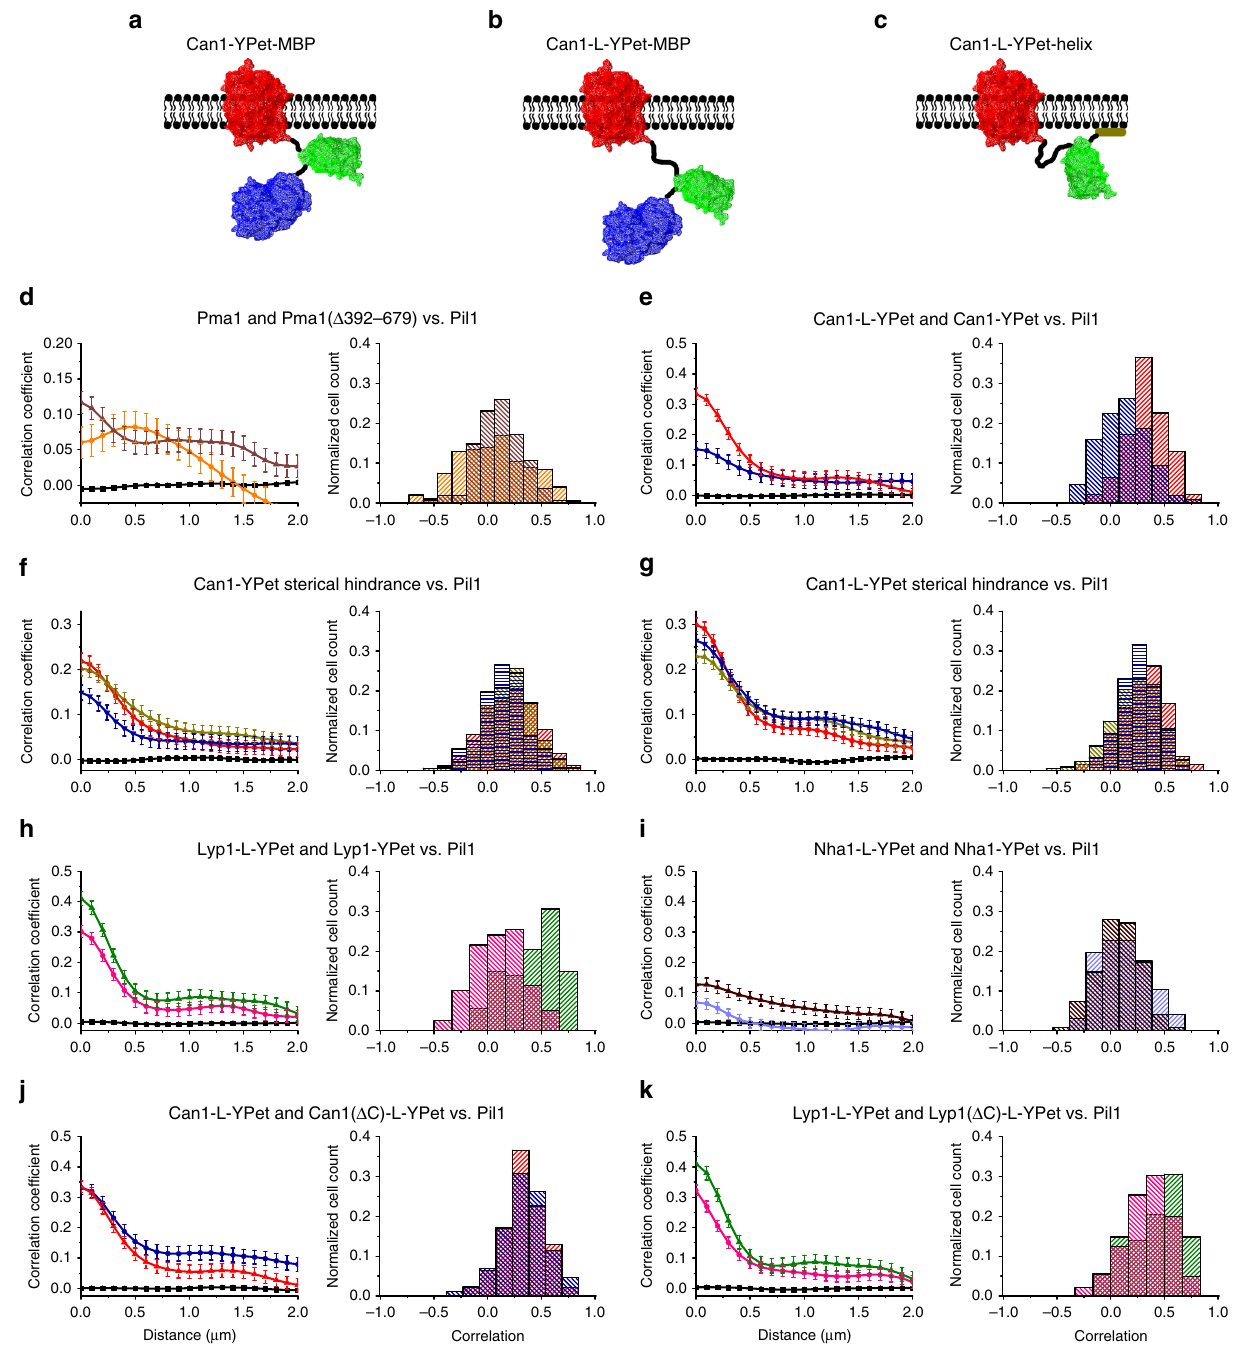
Fig. 5 Steric occlusion from MCC/eisosomes. Schematic of transporter constructs ( a – c ) to investigate the possible hindrance for MCC/eisosome entry by engineering cytoplasmic domains onto Can1. Maltose-binding protein (MalE) (blue) attached to c Can1-YPet and d Can-L-YPet, and e Can1-L-YPet tethered to the membrane via an amphipathic α -helix and lipid moiety; the helix corresponds to the C-terminal 51 amino acids of Gap1 33 ; L is linker as described in the methods section. Cross-correlation analysis of BY4742 cells expressing Pil1-mKate2 together with d Pma1-YPet (orange; n = 201) or Pma1 ( Δ 392 – 679)-YPet (brown; n = 169); the Pma1 constructs were expressed from a single copy plasmid under the control of the Pma1 promoter. Cross- correlation of chromosomally labeled Pil1-mKate2 vs. chromosomally YPet-tagged target protein: e Can1-L-YPet (red; n = 93) and Can1-YPet (blue; n = 92). f Can1-YPet (red; n = 165), Can1-YPet-MBP (blue; n = 147), Can1-YPet-Gap1C (tan; n = 172); g Can1-L-YPet (red; n = 202), Can1-L-YPet-MBP (blue; n = 152), Can1-L-YPet-Gap1C (tan; n = 226); h Lyp1-L-YPet (green; n = 108) and Lyp1-YPet (magenta; n = 119); i Nha1-L-YPet (light blue; n = 69) and Nha1- YPet (pink; n = 122); j Can1-L-YPet (red; n = 93) and Can1( Δ C)-L-YPet (blue; n = 88); k Lyp1-L-YPet (green; n = 108) and Lyp1( Δ C)-L-YPet (magenta; n = 146). The left graph of each panel shows the correlation coef fi cients over distance for the various proteins with error bars representing standard error of the mean; the right graph of each panel shows the histograms of the probability distributions of single-cell cross-correlations; n represents number of cells